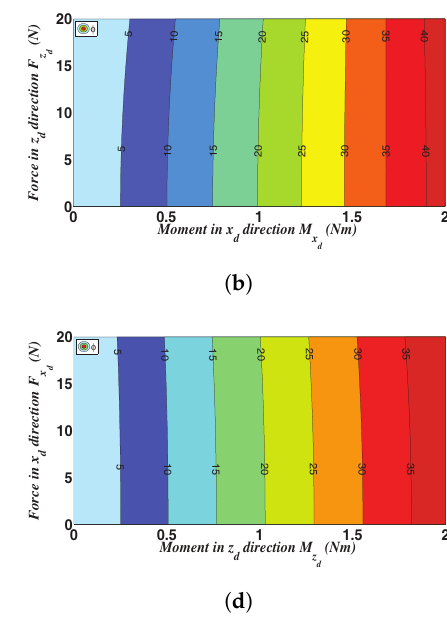
, and force, F y ; ( d ) moment, M z d d , and force, F z d d